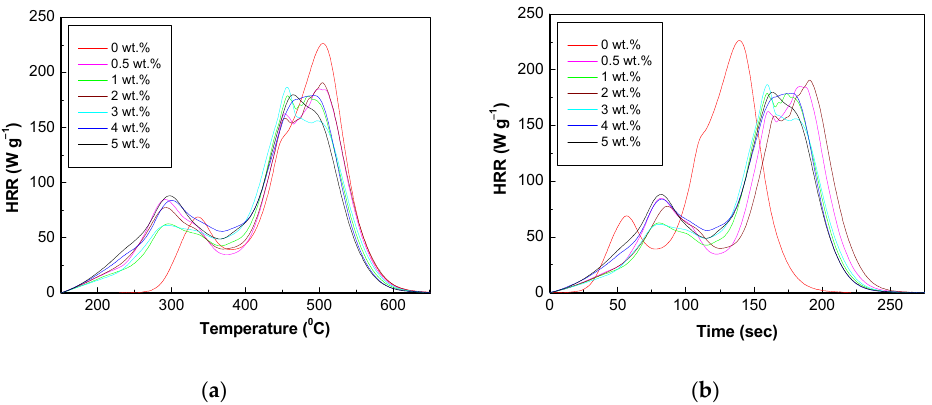
Figure 7. Dependence of heat release rate (HRR) on temperature ( a ) and time ( b ) for samples labeled as PVC spheres (red curve) and composites based on the PVC spheres and GO sheets with the GO concentration equal to 0.5 wt.% (magenta curve), 1 wt.% (green curve), 2 wt.% (wine curve), 3 wt.% (cyan curve), 4 wt.% (blue curve), and 5 wt.% (black curve).